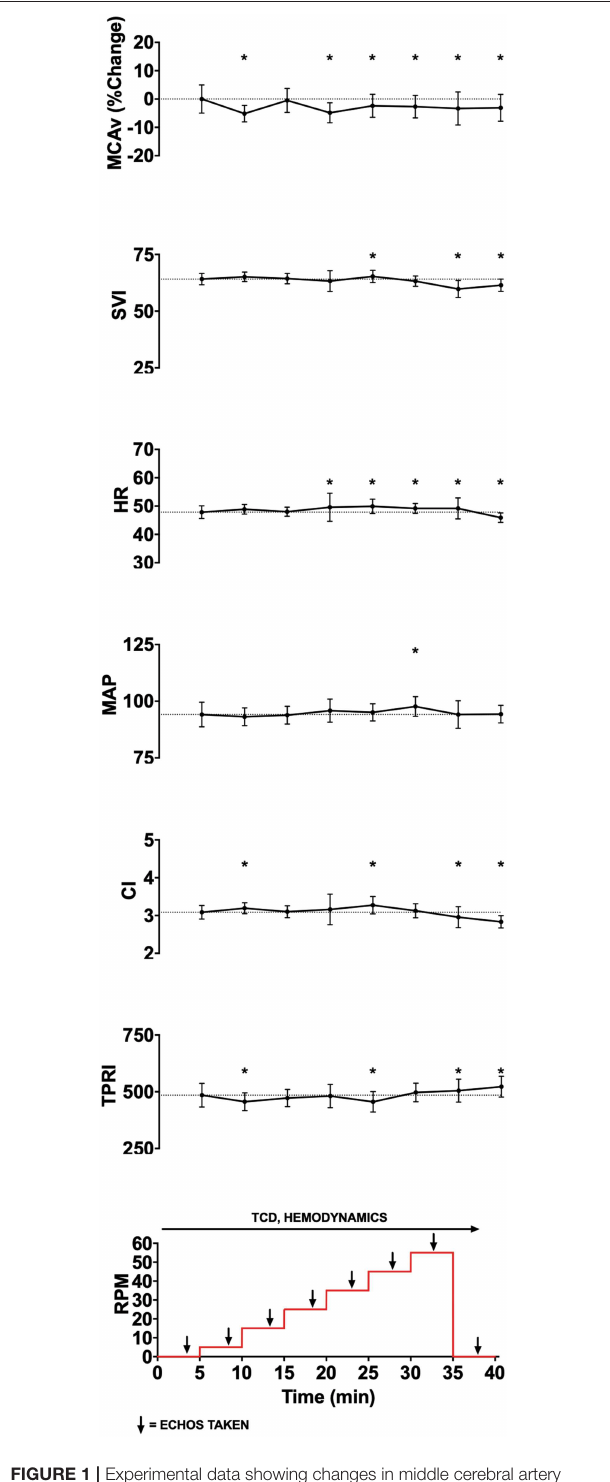
FIGURE 1 | Experimental data showing changes in middle cerebral artery blood flow velocity (MCAv, % change from baseline, cm/s), stroke volume index (SVI, mL/m 2 /beat), heart rate (HR, beats per minute), mean arterial pressure (MAP, mmHg), cardiac index (CI, L/min/m 2 ), total peripheral resistance index (TPRI, mmHg /m 2 L min), global longitudinal strain (GLS), and